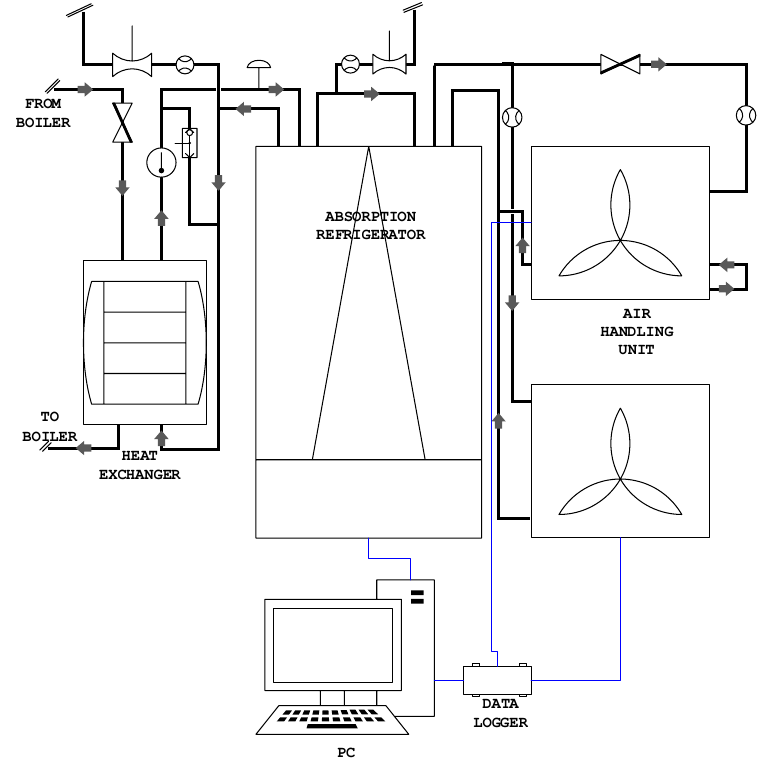
Figure 1. Absorption refrigeration test